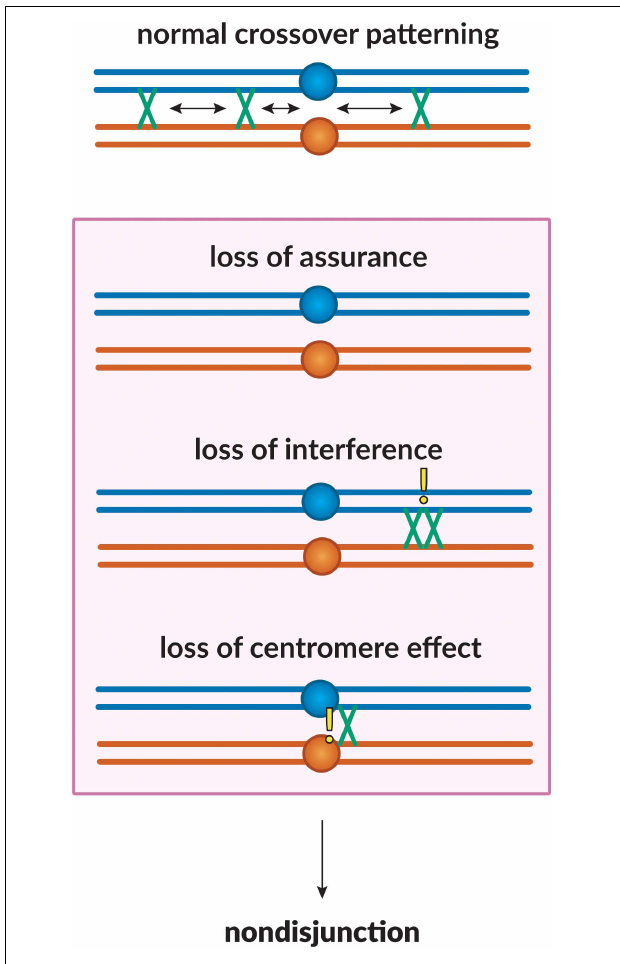
FIGURE 2 | Crossover patterning phenomena. The proper placement of crossovers along the chromosome is governed by three patterning phenomena. Homologous chromosomes are shown in blue and orange, with crossovers between them shown in green. Loss of assurance results in a lack of crossing-over between a pair of homologs; loss of interference results in two crossovers being placed in close proximity to one another; loss of the centromere effect results in centromere-proximal crossovers. These phenomena can lead to a failure in proper chromosome segregation, leading to